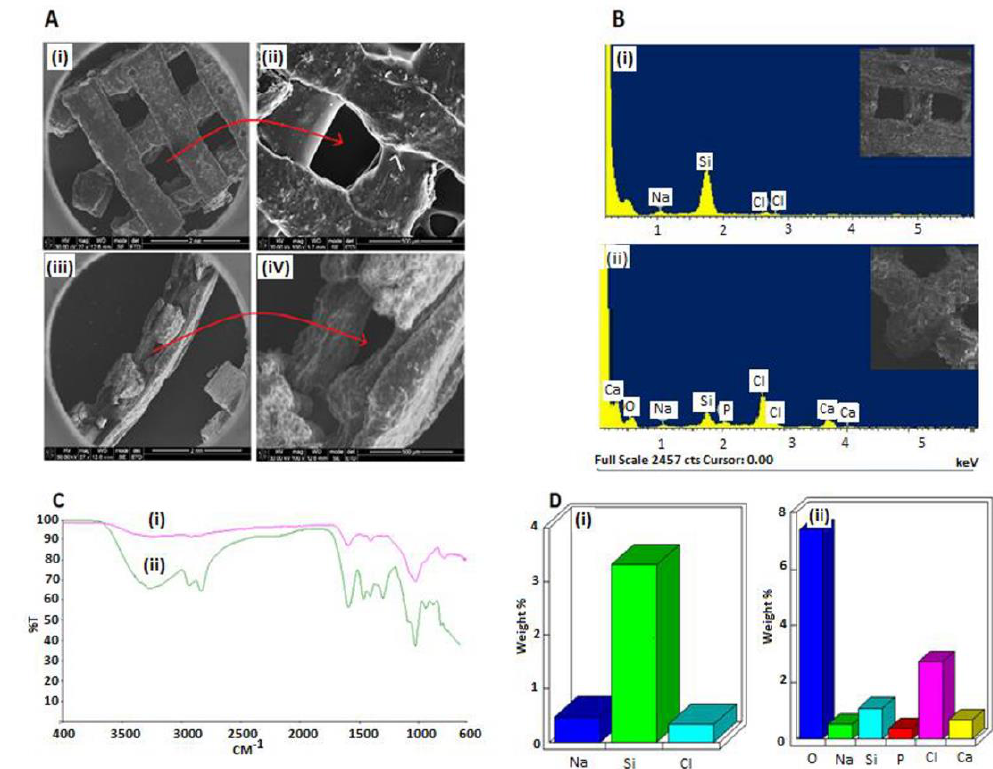
Figure 2. The cross-section and biomineralization investigation of the printed scaffold where ( A ) depicts the SEM (i) image of the surface section of the printed scaffold, (ii) magnified image of the surface section of the printed scaffold, (iii) image of the cross-section of the printed scaffold, and (iv) magnified image of the cross-section of the printed scaffold, ( B ) depicts the EDX analysis for (i) scaffold before immersion (non-mineralized) and (ii) after immersion in SBF (pH 7.4, 37 °C), ( C ) depicts the FT-IR spectra for (i) non-mineralized and (ii) mineralized scaffold, and ( D ) depicts the quantitative results of (i) non-mineralized and (ii) mineralized.